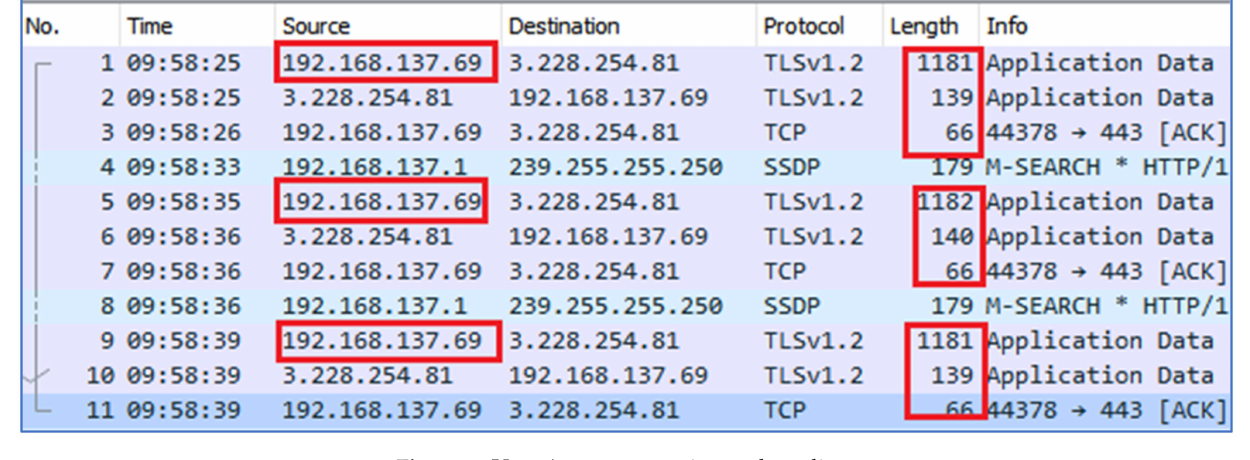
Figure 7. User A message typing and sending.